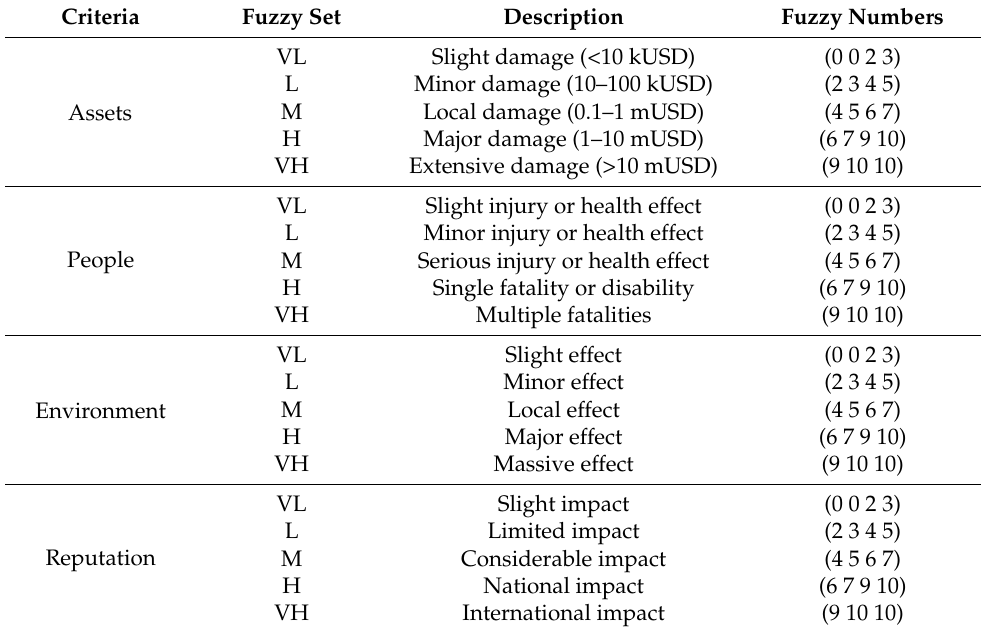
Table 1. Selection criteria for failure modes severity evaluation.